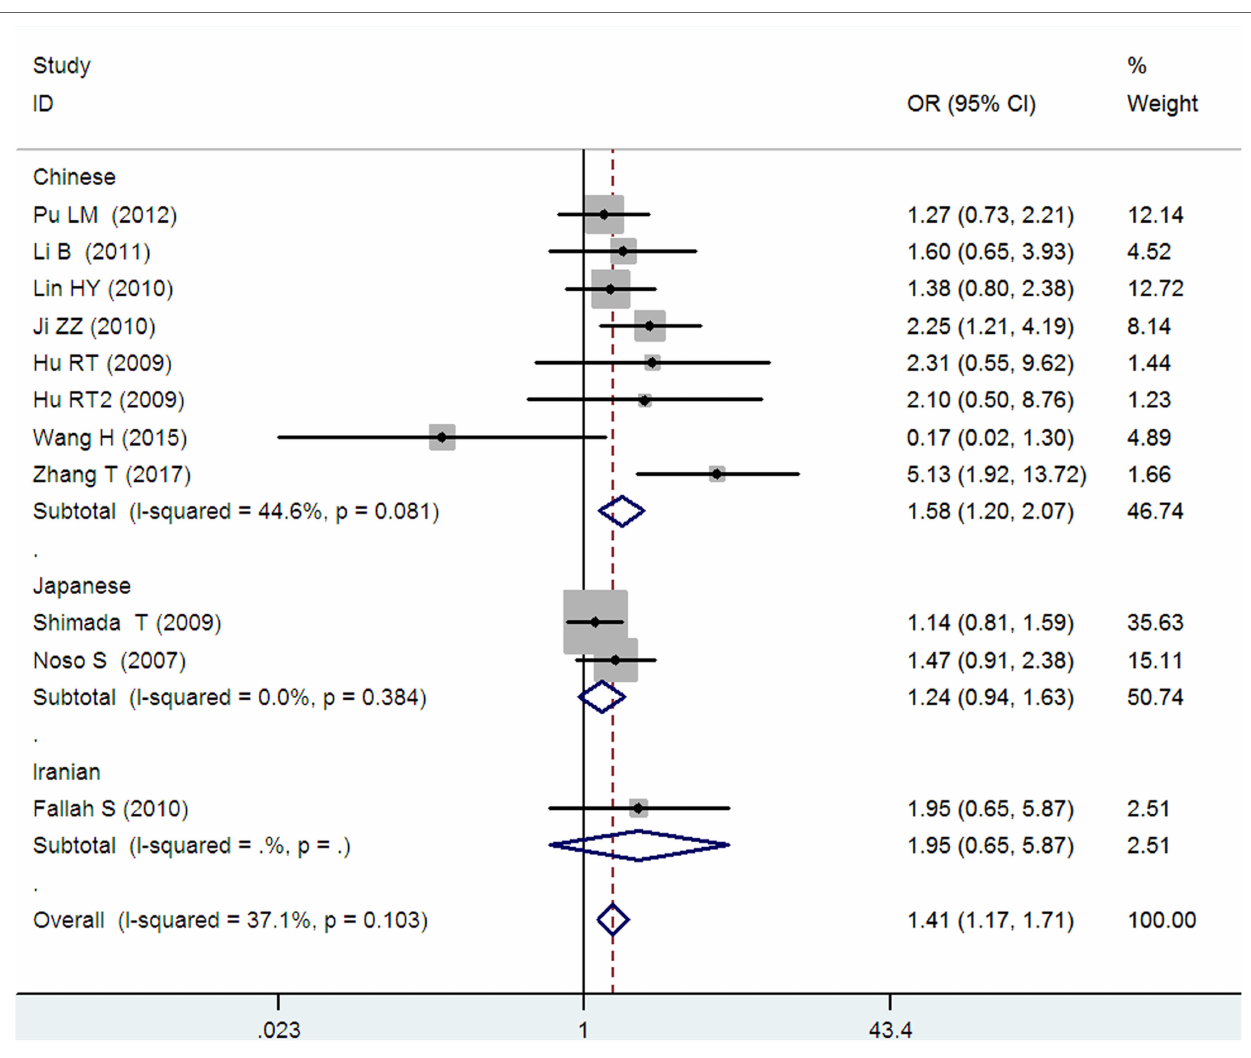
FigUre 4 | Forest plot of type 2 diabetes mellitus associated with small ubiquitin-like modifier 4 gene M55V polymorphism under a homozygous genetic model (VV vs.